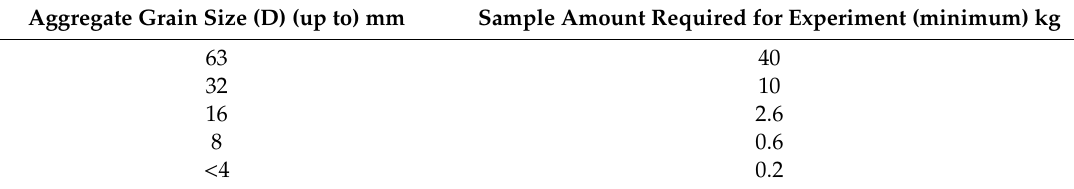
Table 21. Mass of test specimens for normal aggregates.